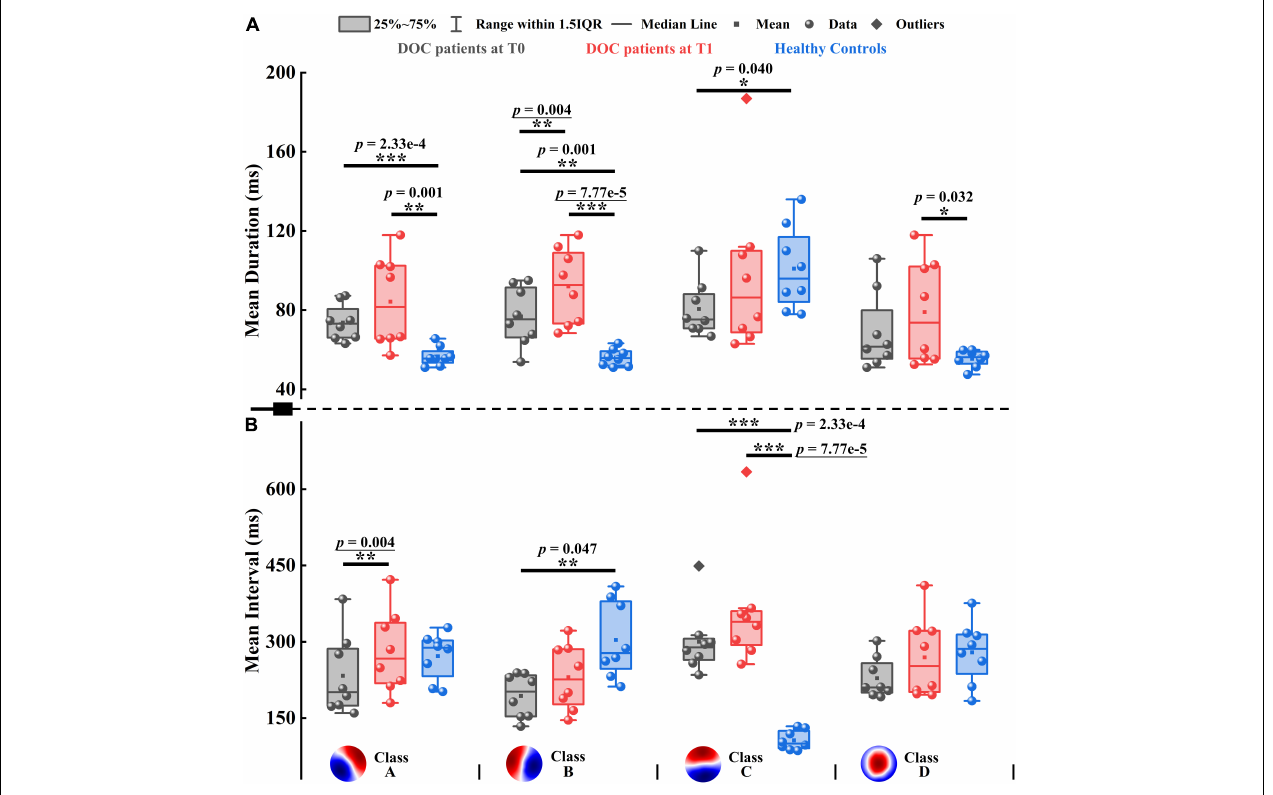
FIGURE 4 | Mean duration and mean interval of patients with DOC and healthy controls. (A) Mean duration. (B) Mean interval. Four microstate templates of patients with DOC are shown at the bottom of the figure. * p < 0.05, ** p < 0.01, *** p < 0.001; p -value with an underline indicates the minimum obtainable p -value is